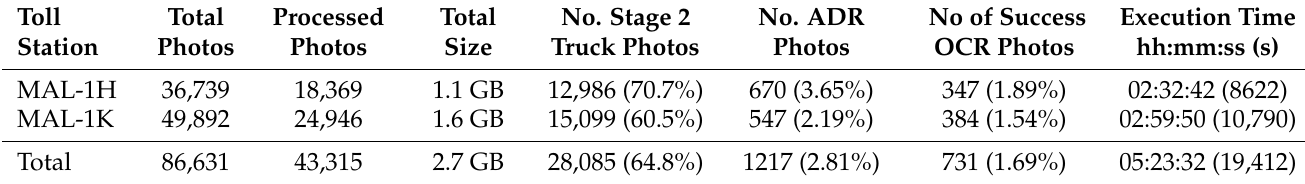
Table 6. Results of the ADR-Det detection execution performance on a realistic dataset, using a 6-core/12threads i7-8700 - 3.2 GHz system with 32 GB RAM (2 × 2666 MHz DDR4), under Ubuntu Linux 20.04.3 LTS, without GPU